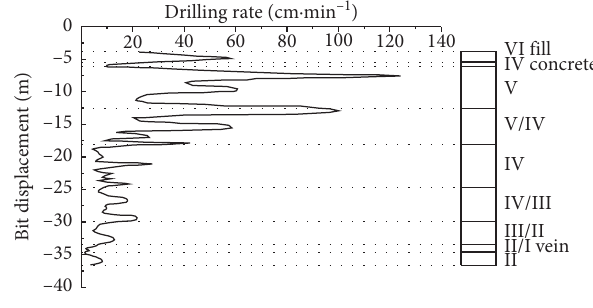
Figure 7: Grilling rate change graph.